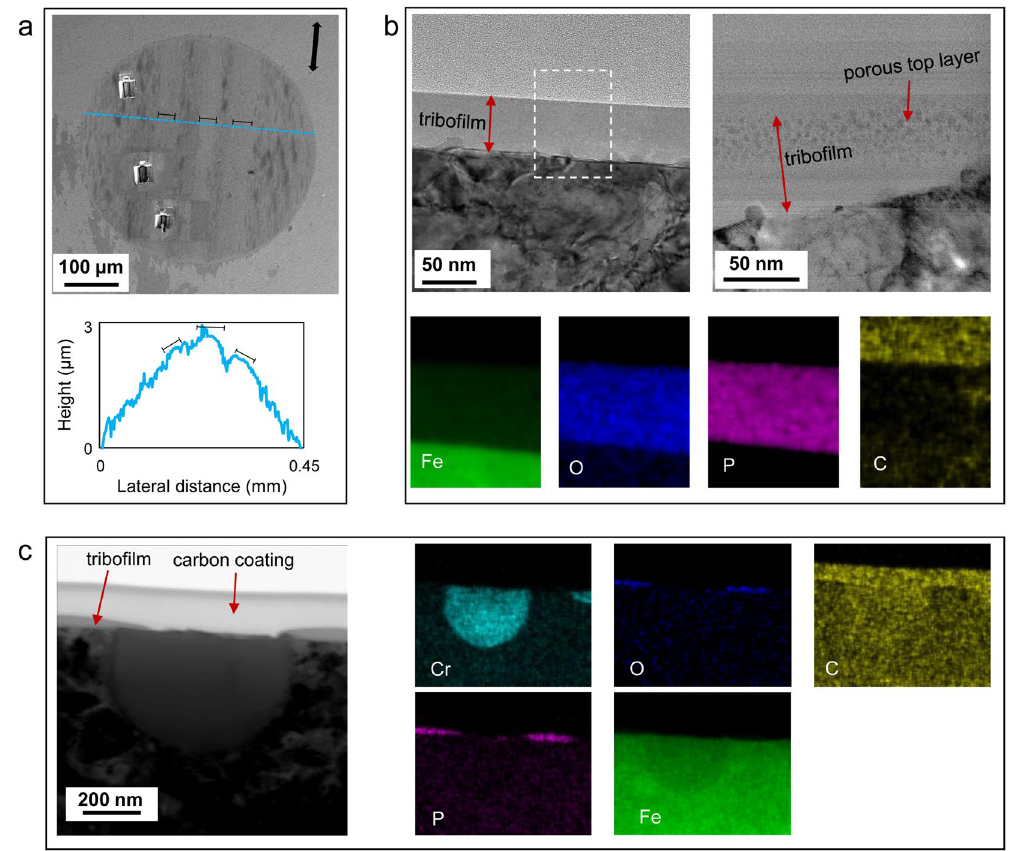
Figure 1. Morphological and compositional characterization of the worn surface on the steel ball lubricated by the base oil with 1% IL. ( a ) SEM image of the wear scar with a 2D profile; the arrow indicating the sliding direction and the three brighter stripes are marked (note: the height and lateral distance are not proportional). ( b ) Cross-sectional BF-STEM images of the tribofilm at two locations showing an amorphous structure of 50 nm and a two-layered structure ( a porous top layer embedded with nanoparticles and an amorphous bottom layer); EDS elemental maps indicating the tribofilm is rich in Fe, O, and P. ( c ) A Cr grain with little tribofilm grew on